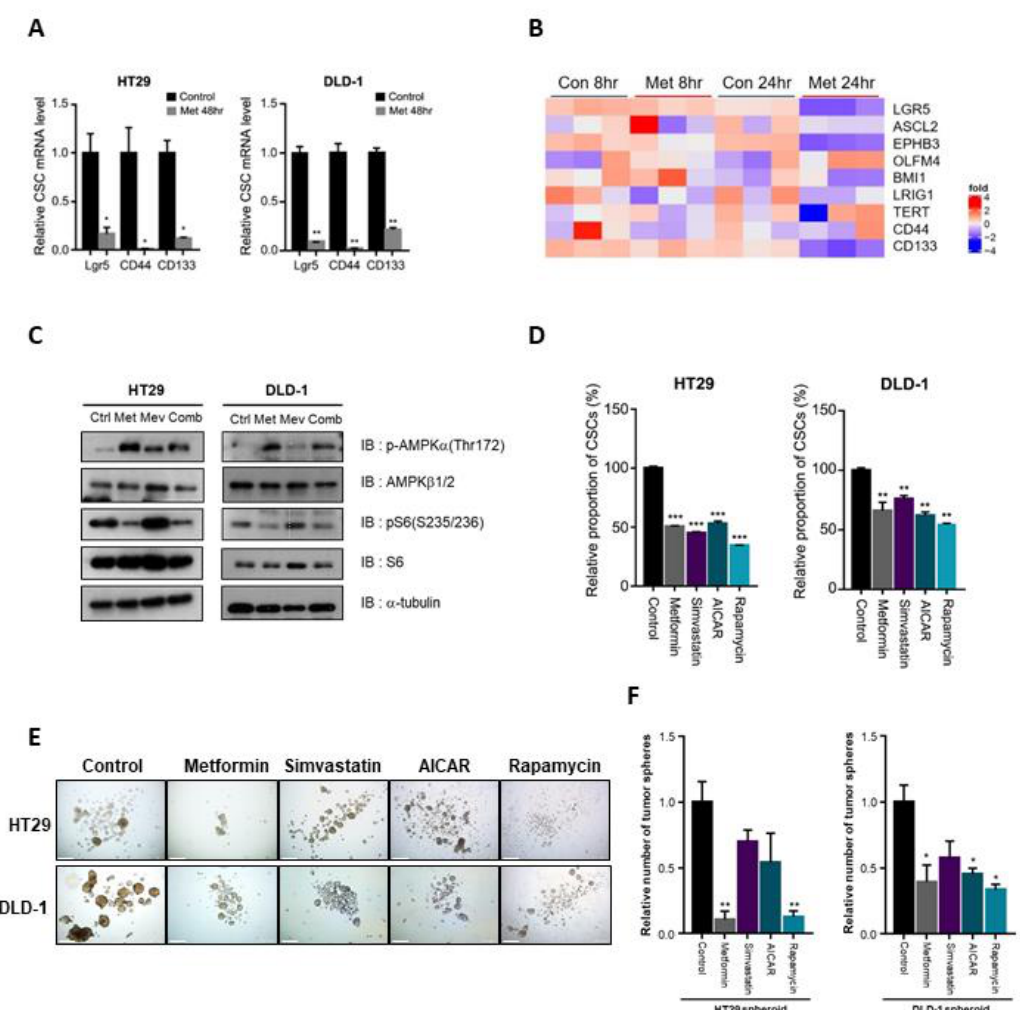
Figure 1. Suppression of cancer stem cells by metformin, statin, AMPK activator, and mTOR inhibitor. ( A ) After 48 h of treatment with metformin (10 mM), mRNA levels of CSC markers in HT29 and DLD-1 cells were analyzed by qPCR. ( B ) Heatmap analysis representing transcripts of CSC markers using public RNA-sequencing data of LoVo cells treated with and without metformin for 8 h and 24 h (GSE76342). ( C ) Western blot analysis of p-AMPK and p-S6 expression levels in HT29 and DLD-1 cells after 48 h of treatment with control vehicle, metformin (10 mM), mevalonate (1 mM), or combination (metformin (10 mM) and mevalonate (1 mM)). ( D ) HT29 and DLD-1 cells were treated with metformin (10 mM), simvastatin (2 μM), AICAR (1 mM), or rapamycin (200 nM). After 48 h, the proportions of CD44+/CD133+ cells were analyzed by flow cytometry using anti-CD44-FITC and anti-CD133-PE. ( E , F ) In tumor sphere cultures treated with metformin (10 mM), simvastatin (2 μM), AICAR (1 mM), or rapamycin (200 nM) for 7 days, the number of tumor spheres ( ≥ 200 µm in diameter) was counted and compared to the counts in control cultures. Data are expressed as the mean ± standard error of three independent experiments; * p < 0.05, ** p < 0.01, and *** p < 0.001 (compared with control).